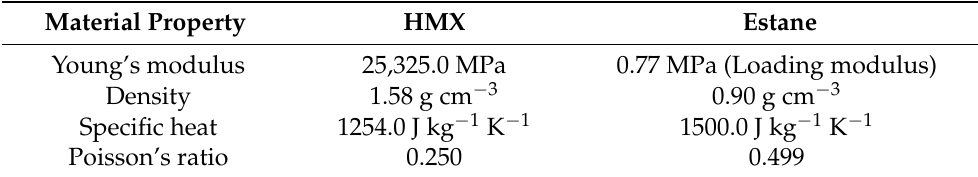
Table 1. Material properties [1].